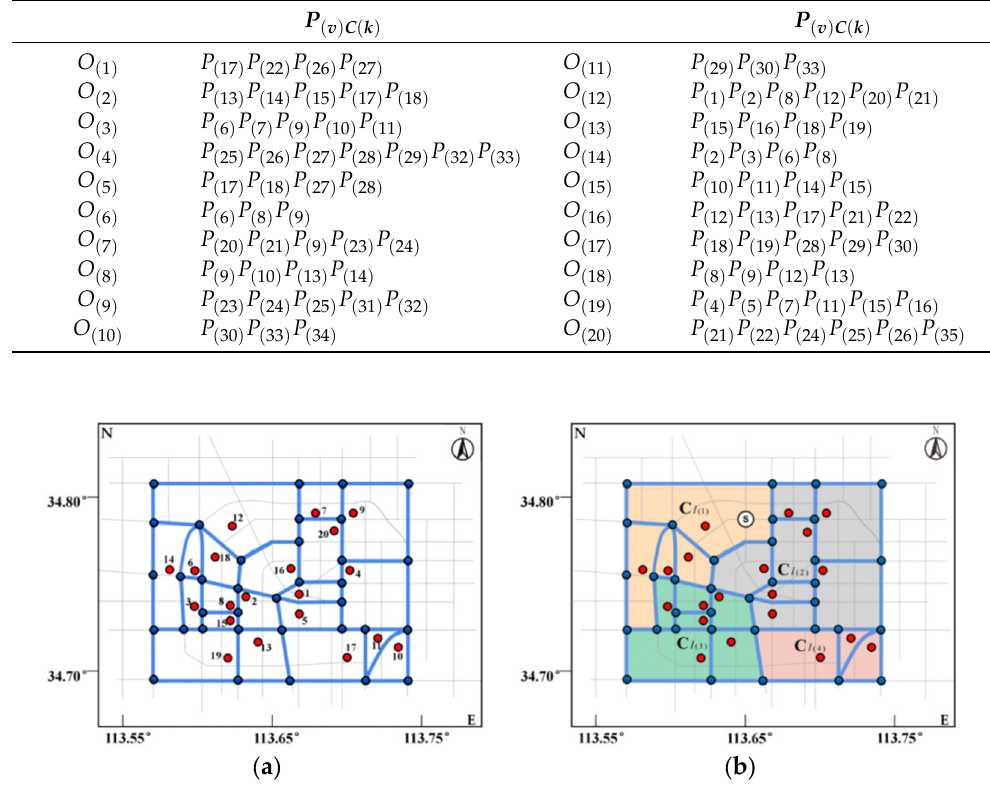
Figure 7. The tourist attraction cellular space C and cluster distribution generated by the algorithm. ( a ) shows the basic structure of space C and clusters. ( b ) shows the cluster results.